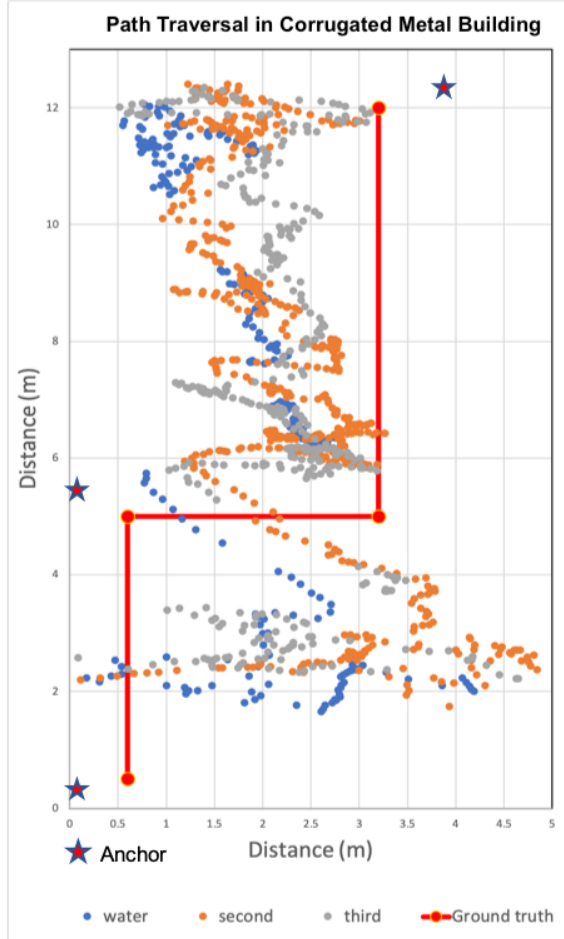
Figure 20. UWB Path testing at Fire Training